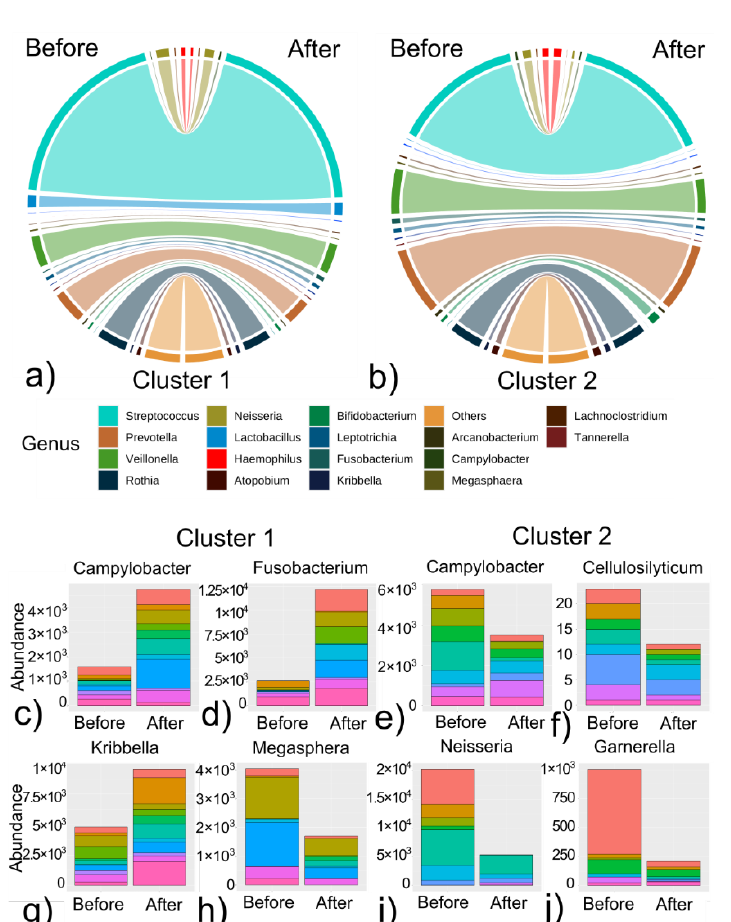
Figure 4. Clustering analysis of microbiome changes after anti-cancer therapy: ( a , b ) chord plots represent the relative abundance estimated for a perfect profile in Cluster 1 and Cluster 2. Values before and after therapy are right- and left side of a circle respectively. Colors for both chord plots correspond to the genus (legend “GENUS”); ( c – j ). Stacked bar plots represent the difference in relative abundance specific for clusters (Cluster 1 = c , d , g , h ; Cluster 2 = e , f , i , j ). Color layers represent patients for a specific group and they are consequently used within a group.